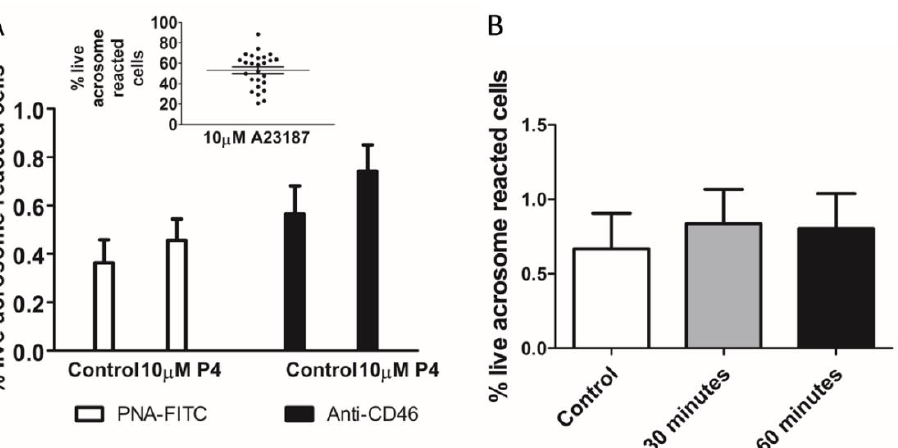
Figure 1. P4 does not significantly increase completed acrosome reaction (AR). ( A ). Measurement of the AR after 30-min exposure to P4 (10 μM ) in density gradient prepared human sperm incubated in capacitating conditions for 3 h. There is no significant difference between the percentage of acrosome reaction reported by flow cytometry using PNA-FITC or anti-CD46 APC-conjugated monoclonal antibody of sperm incubated with 10 μM P4 for 30 min (paired data of 26 samples from 18 donors). AR induction by ionophore A23187 in these samples detected using anti-CD46 is shown in insert. ( B ). Incubation of sperm with P4 for 60 min does not significantly increase AR ( n = 5 samples from 5 donors). Addition of vehicle (DMSO) served as a negative control.